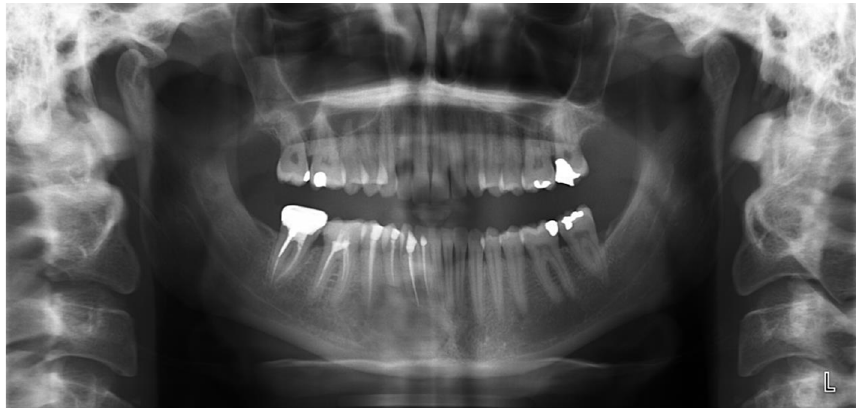
Fig. 4. Follow-up orthopantomogram after